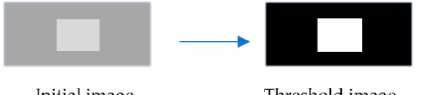
Figure 2. Conceptual representation of the